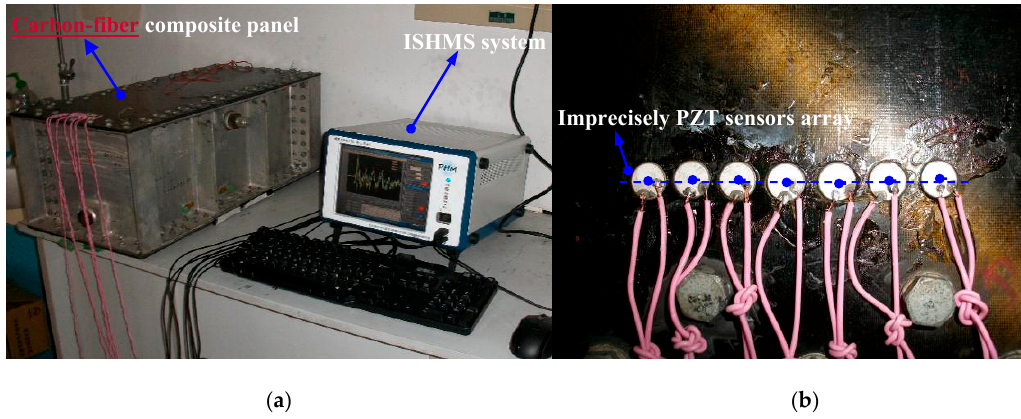
Figure 6. ( a ) Experimental setup and ( b ) imprecise PZT sensors array bonded on the aircraft oil tank structure.